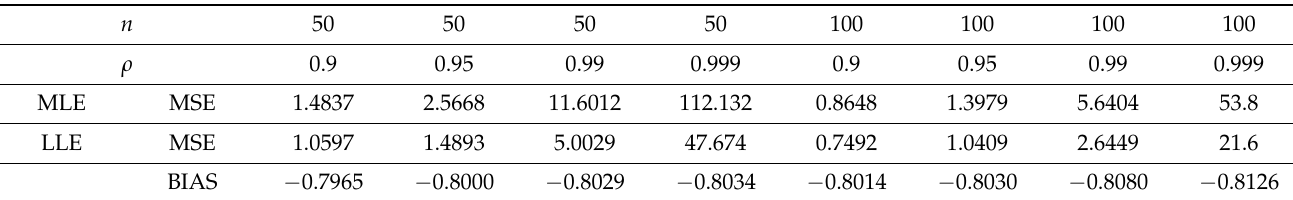
Table 1. Estimated MSEs and Bias for p =